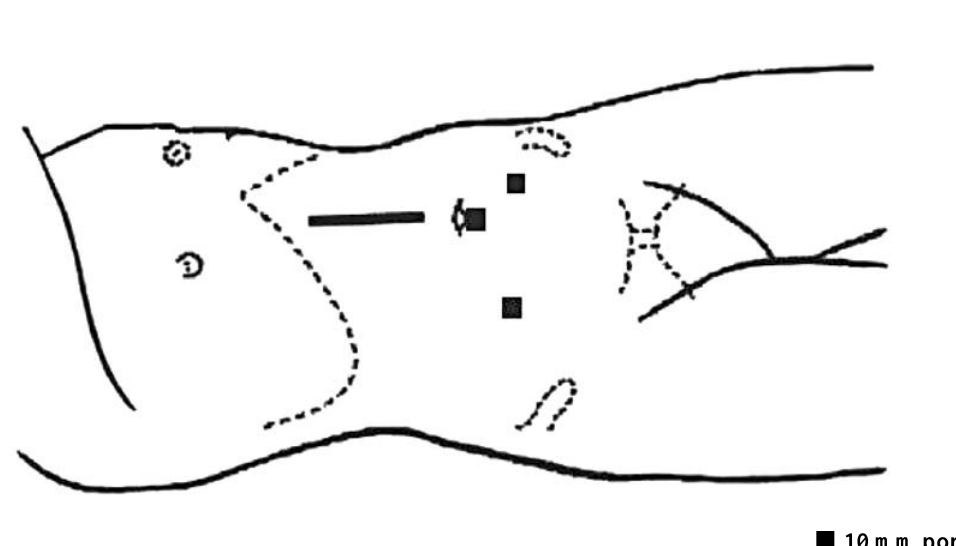
Figure 2 – Bilateral nephrectomy: position of the laparoscopic ports and the manual incision.